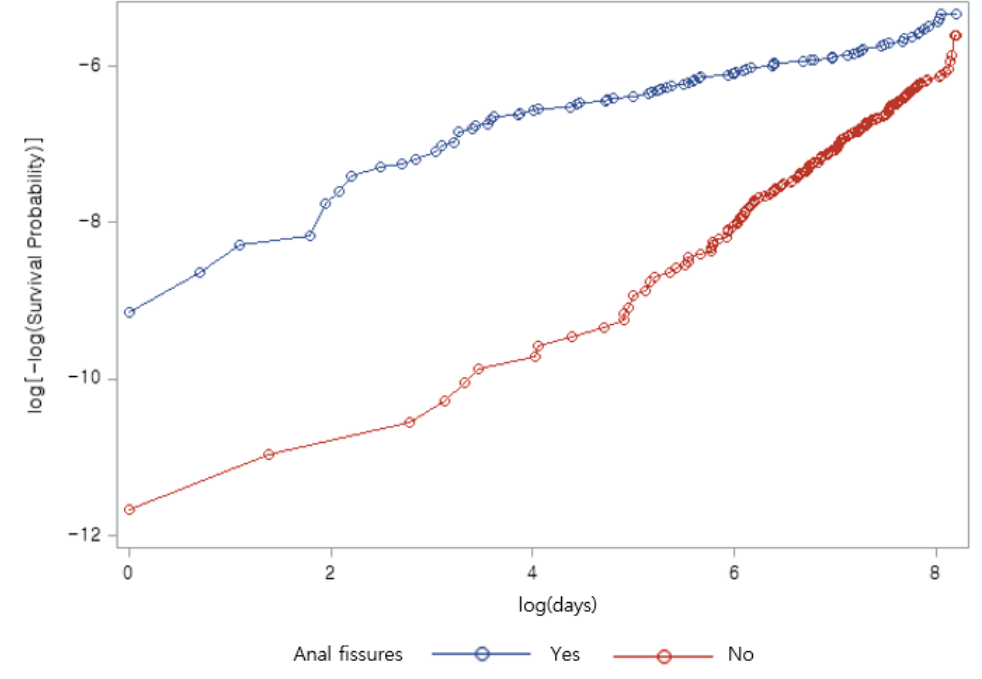
Figure 1. Log-log survival probability test for anal fissures .